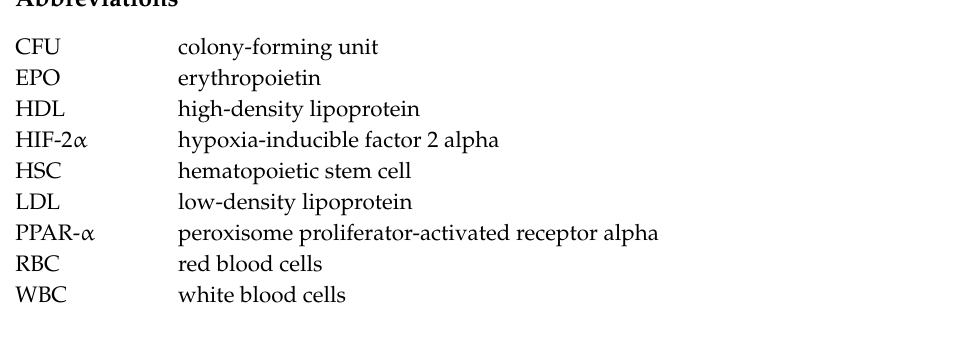
Figure S1: Total bone marrow cell count and total flow cytometry marker